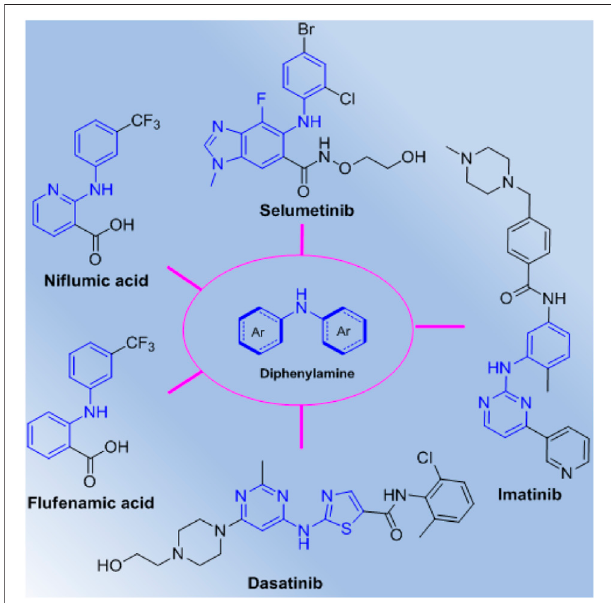
FIGURE 1 | Some typical diarylamine derivatives as drugs.